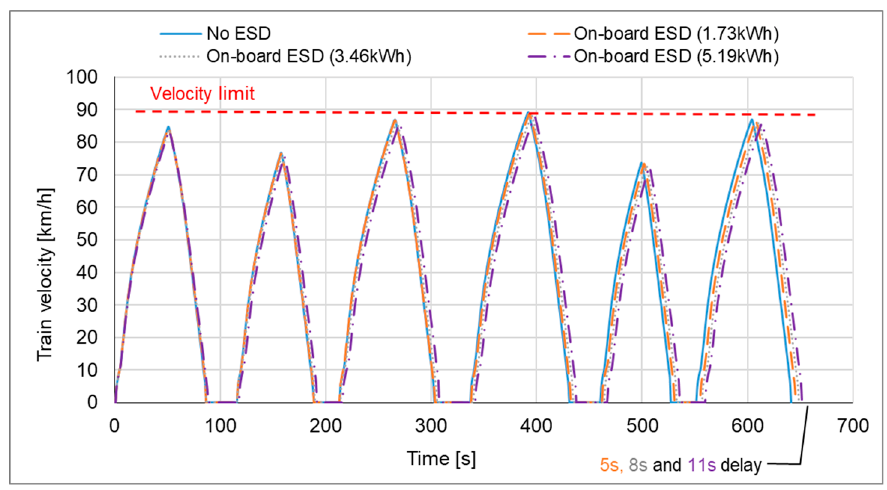
Figure 5. Train velocity for different sizes of on-board ESD (1.73 kWh, 3.46 kWh and 5.19 kWh).